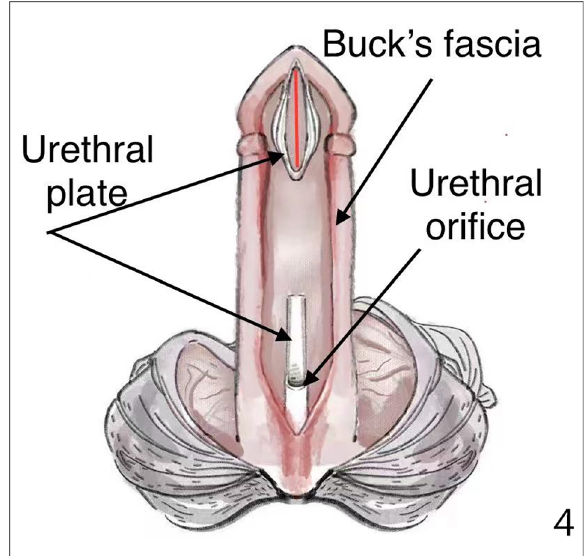
FIGURE 4 The ventral urethral plate was incised transversely in the middle and separated to two parts, and the distal part of the urethral plate was deeply incised longitudinally (red line in Figure 4